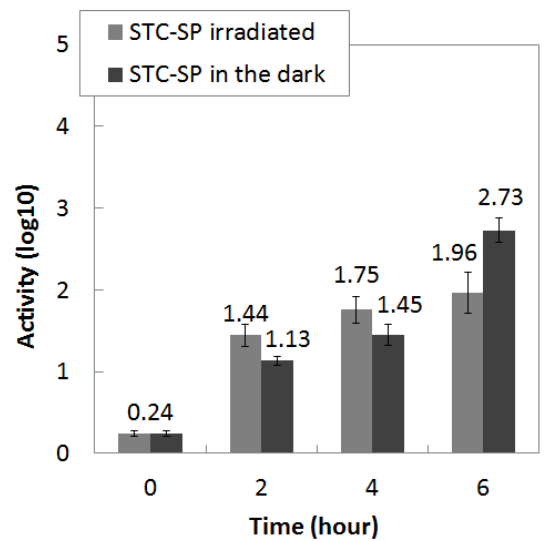
Figure 5. Antibacterial activity of SCT-SP coatings under UV irradiation ( ≈2.5 W/m 2 ) and in the dark. Mean ± SE, n =